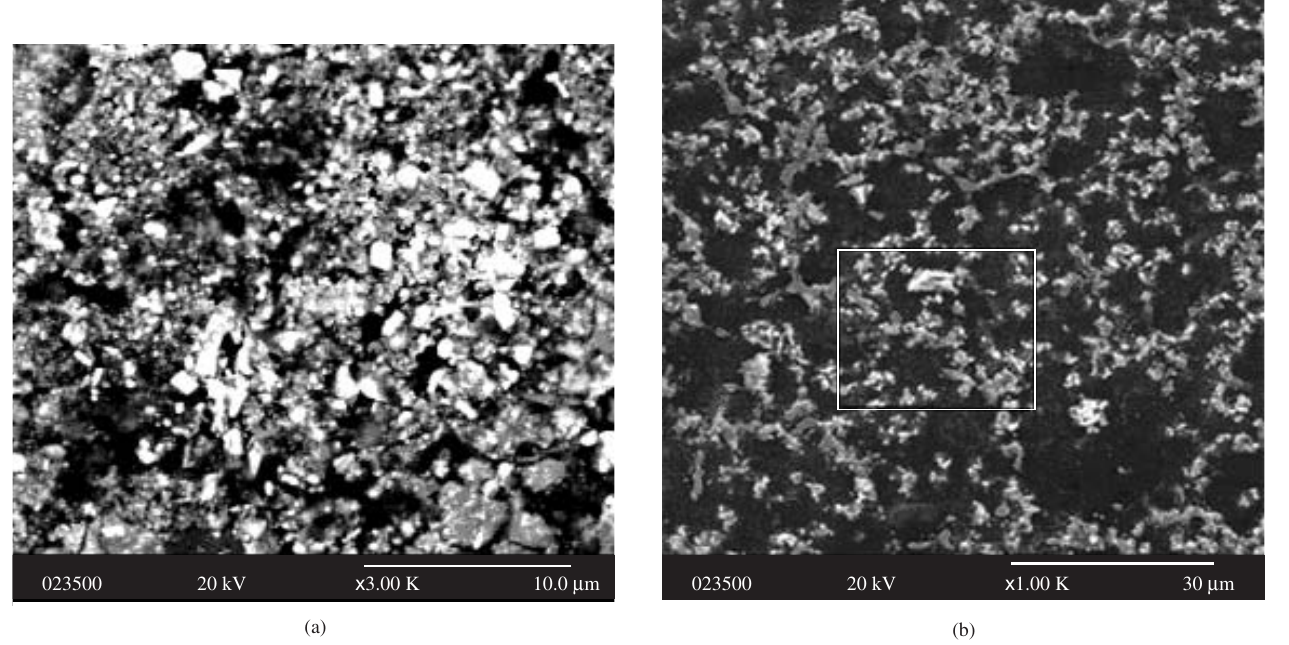
Figure 2. Scanning electron microscope (SEM) analysis of samples a) prefabricated block; and b) magnesium matrix composites.